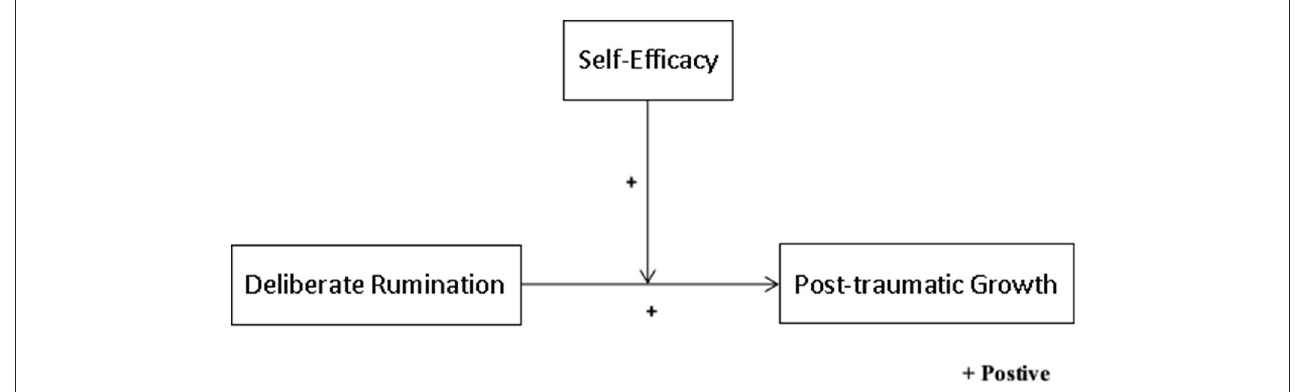
FIGURE1 Graphic representation of relationships between study